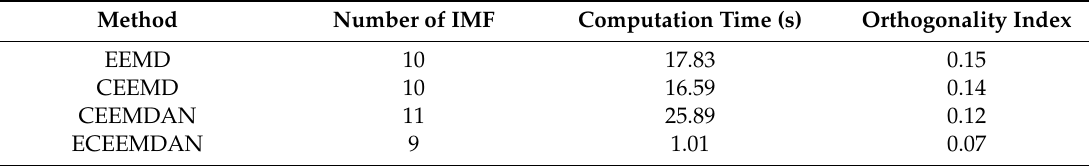
Table 3. Comparison of decomposition e ff ect for the simulation